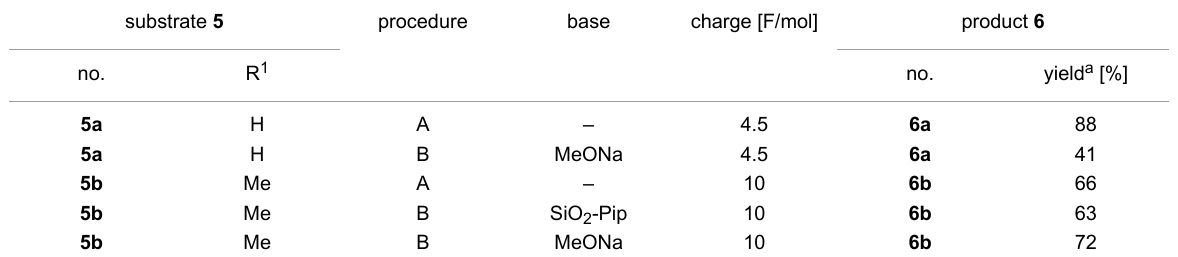
Table 2: Electrochemical α -methoxylation of diethyl 1-( N -acetylamino)alkylphosphonates 5 (R = Me). substrate